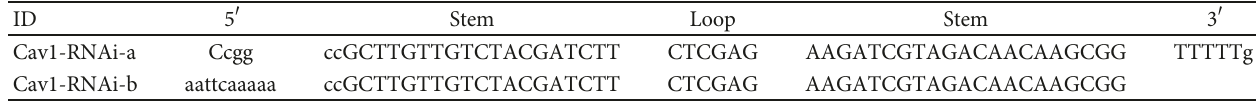
Table 1: The sequence of shRNA to